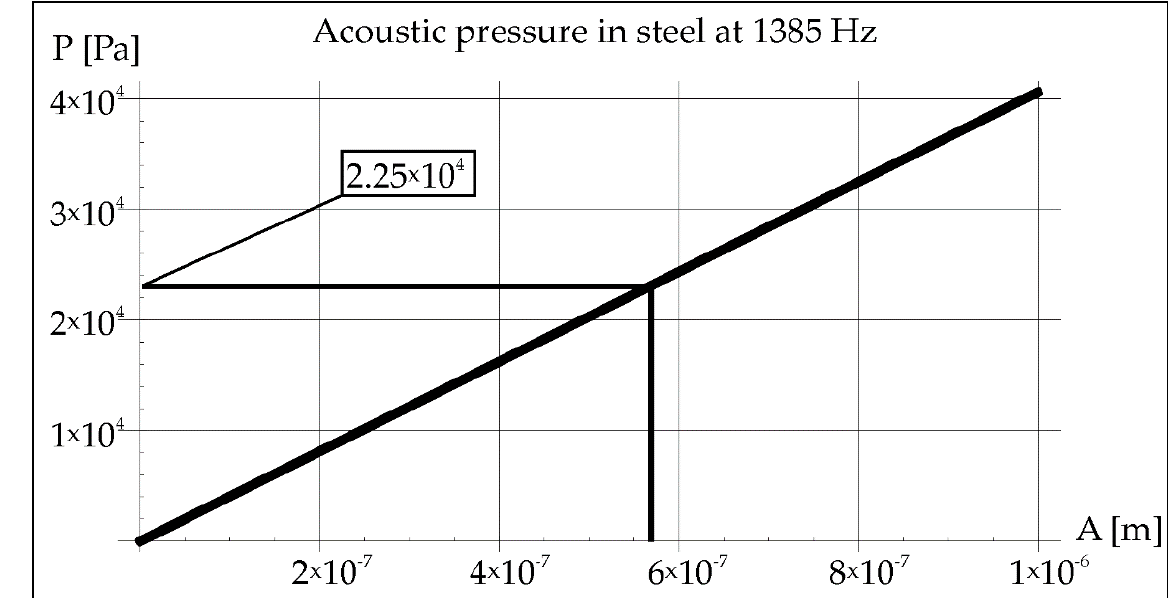
Figure 15. Acoustic pressure in steel at resonance frequency 1385 Hz.